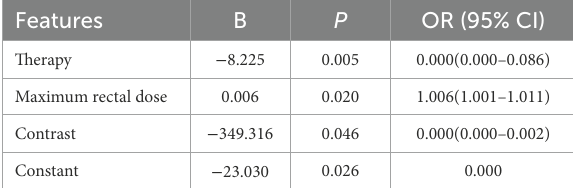
TABLE 2 Result of multivariate logistic regression.